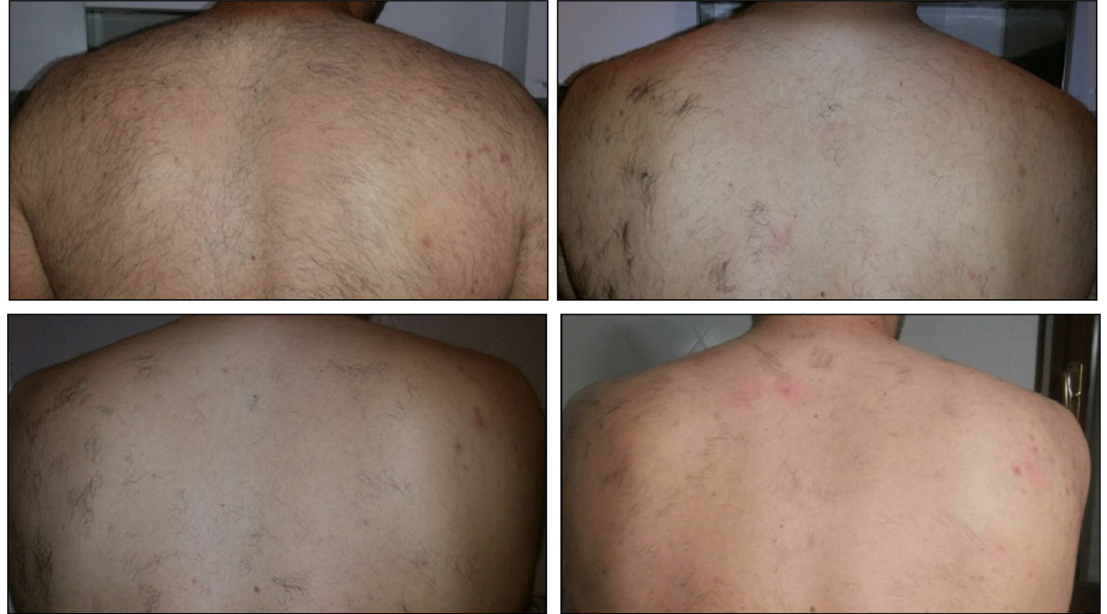
Figure 1. Patient 27 treated with the “in motion” technique before treatment (upper left picture) after two sessions (upper right picture), four sessions (lower left picture), and six sessions (lower right